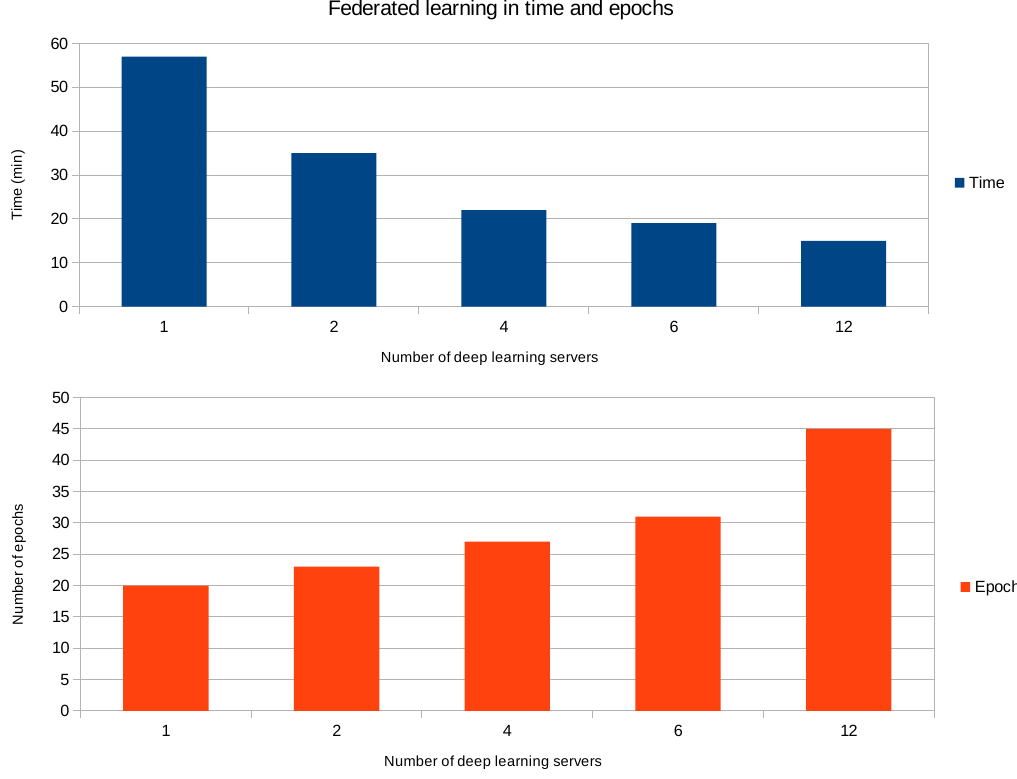
Figure 7. Federated training the autoencoder on benign data only using 20% of the data for